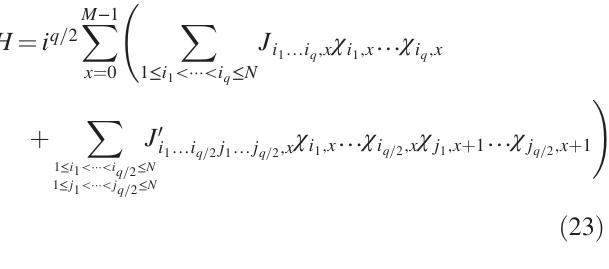
is γ independent, while eq